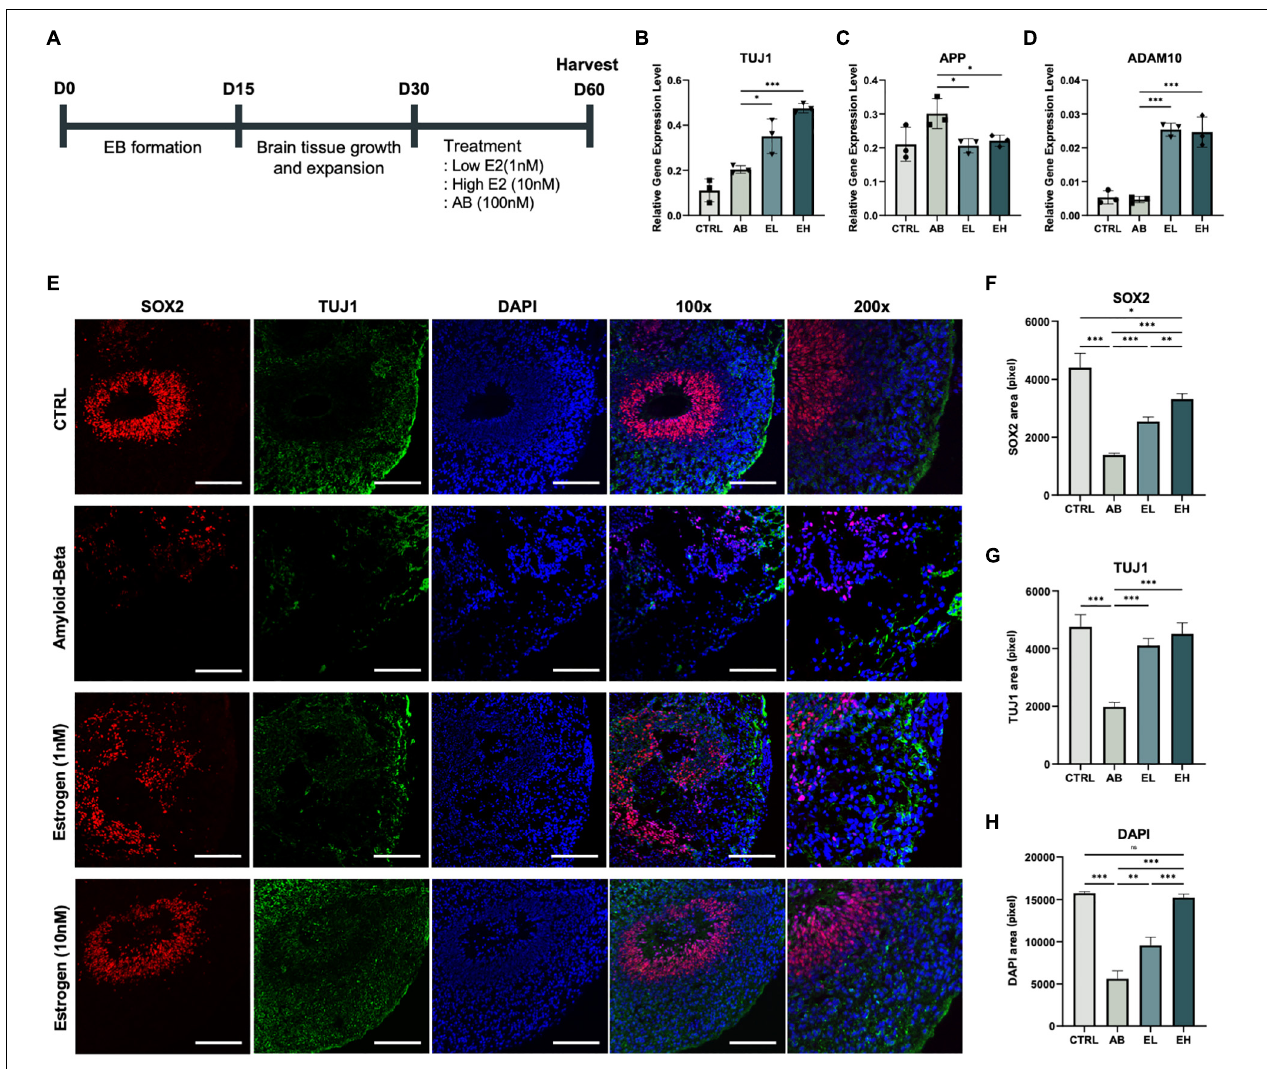
FIGURE 4 | Estrogen treatment of cerebral organoids co-stimulated with amyloid-beta (A β ) enhances the expression of neuronal markers. (A) Schematic representation of the cerebral organoid generation process and treatment with A β peptide and estrogen. Gene expression normalized to that of GAPDH : (B) neuronal markers TUJ1 , (C) amyloid precursor protein marker APP , and (D) alpha-secretase marker ADAM10 . (E) Immunofluorescence assay showing the co-localization of early-stage neuronal marker SOX2 and neuronal markers TUJ1 in samples obtained from experimental and control mice. (F-H) Areas that stained positive for DAPI, SOX2, and TUJ1 were measured using ImageJ. CTRL, control; A β , cerebral organoids treated only with 100 nM A β ; EL, cerebral organoids treated with 100 nM A β and 1 nM estrogen; EH, cerebral organoids treated with 100 nM A β and 10 nM estrogen. t -tests were performed for data analysis ( ∗ P < 0.05, ∗∗ P < 0.01, ∗∗∗ P < 0.001). Values are presented as mean ± standard error of mean. Scale bars, 200 µ